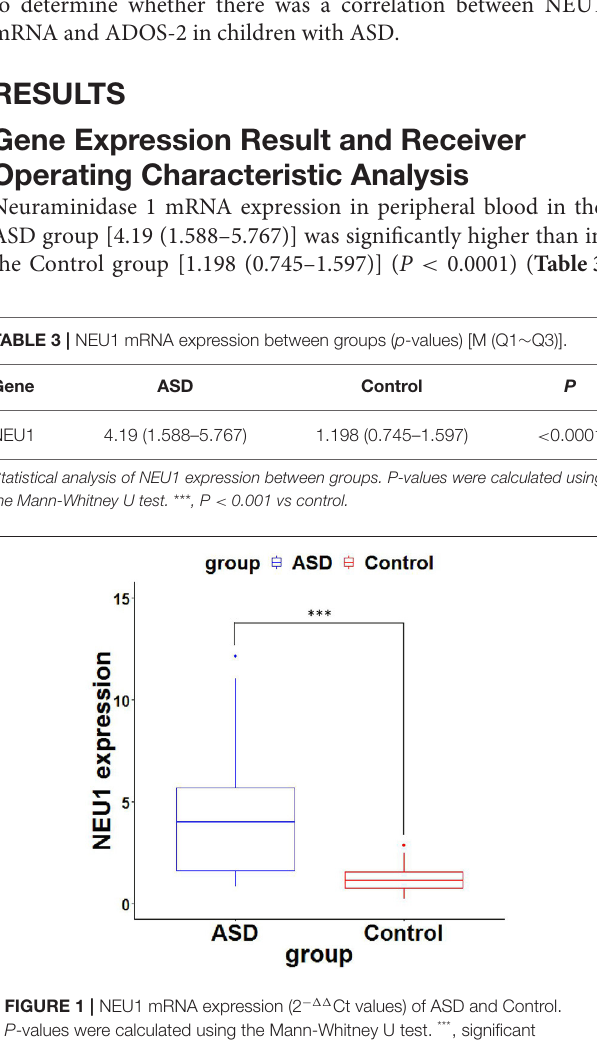
( Figure 3C ). The correlation of NEU1 gene expression results with ADOS-2, SA, and RRB data is listed in Table 4 .